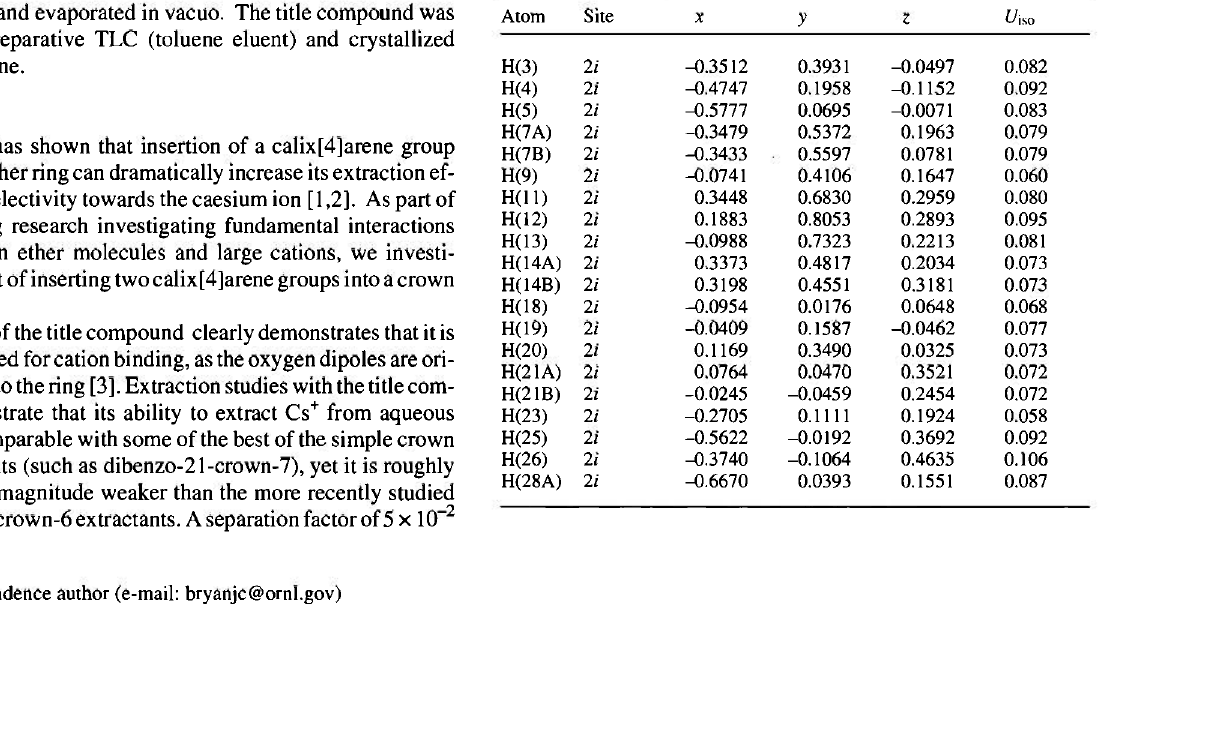
Table 2. Atomic coordinates and displacement parameters (in Ä 2